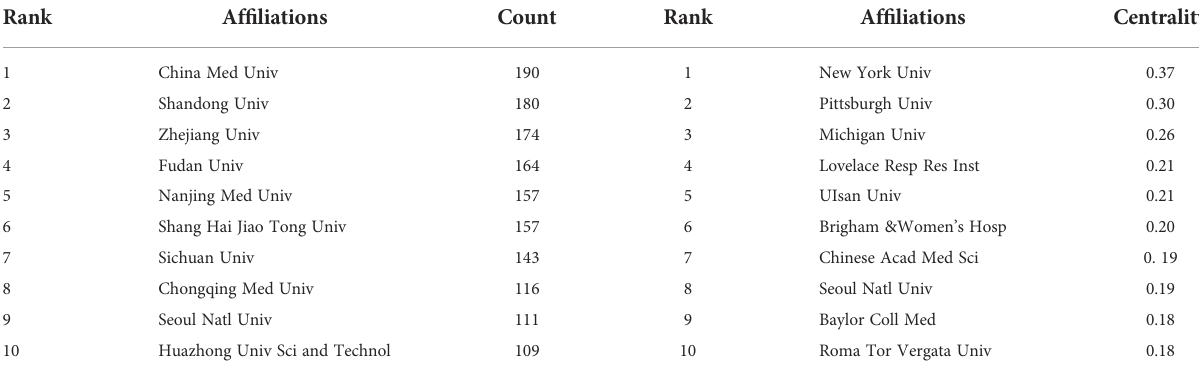
TABLE 3 Top 10 institutions conducting autophagy in lung disease by volume and